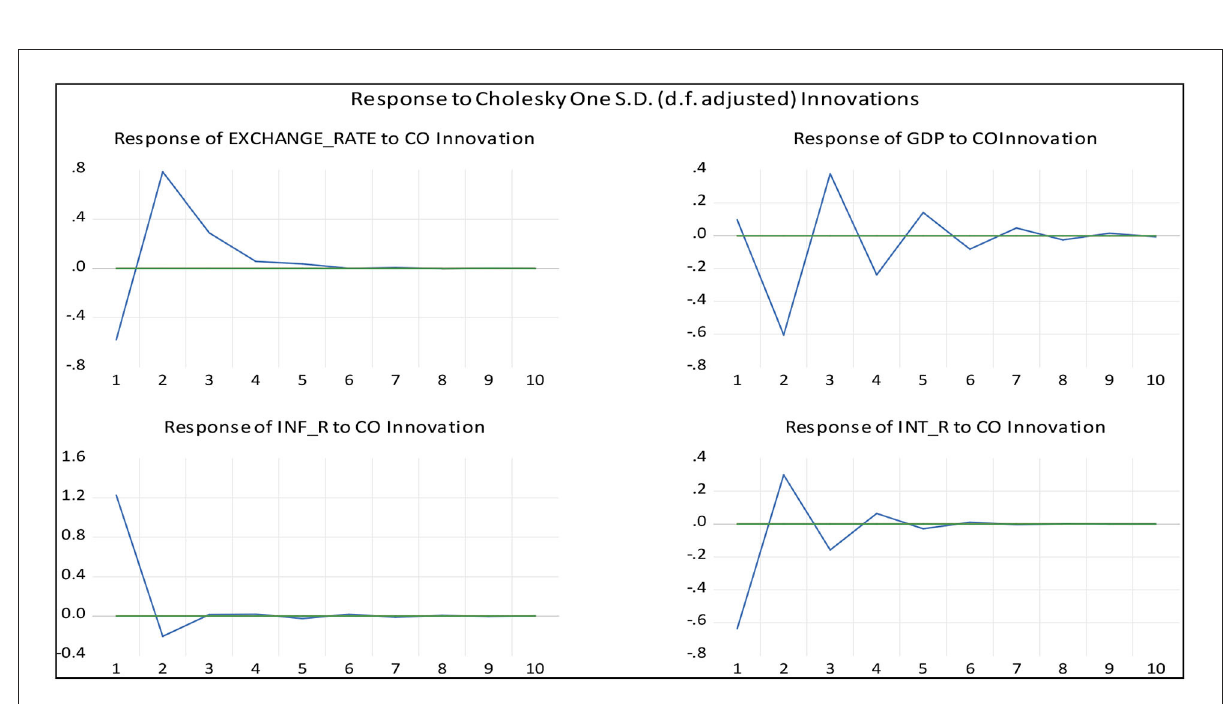
10.98–20.24%, interest rate 0.66–0.88%, and exchange rate 3.22– 16.34% variation over the period of the ten-time horizon in the case of Afghanistan. Similarly, in Bangladesh, variations in